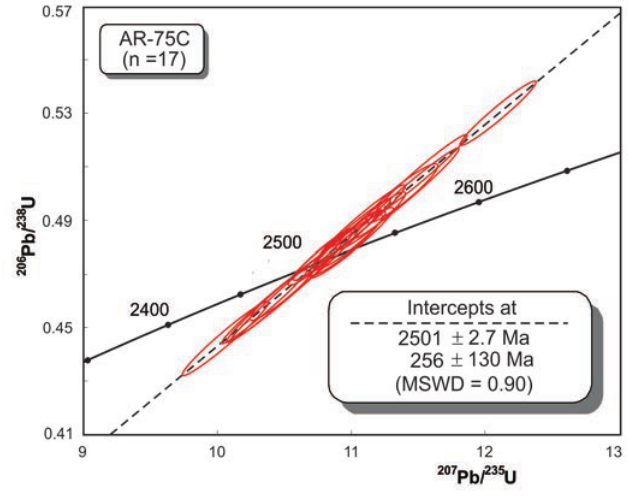
Figure 17 - Concordia diagram for metagabbronorite zircons between 331.15 and 332.05 m deep (sample